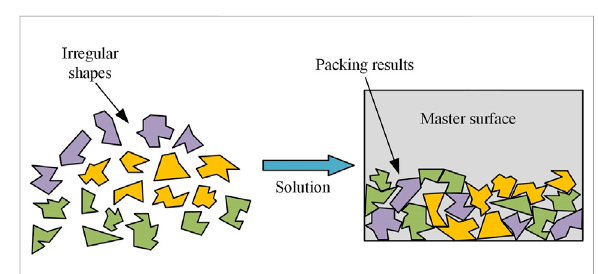
TABLE 3 Variable de fi